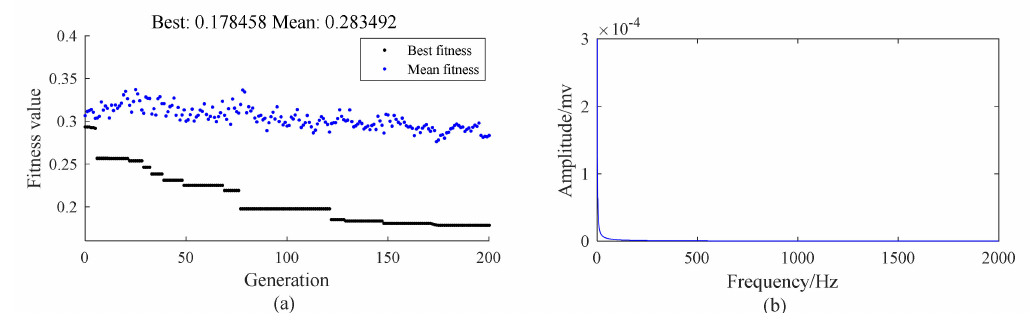
Figure 13. The diagnosis result of the simulation signal of the bearing with the outer race fault processed by the Optimal Wavelet Packet Transform (OWPT): ( a ) the training performance of the OWPT; ( b ) the squared envelope spectrum result.